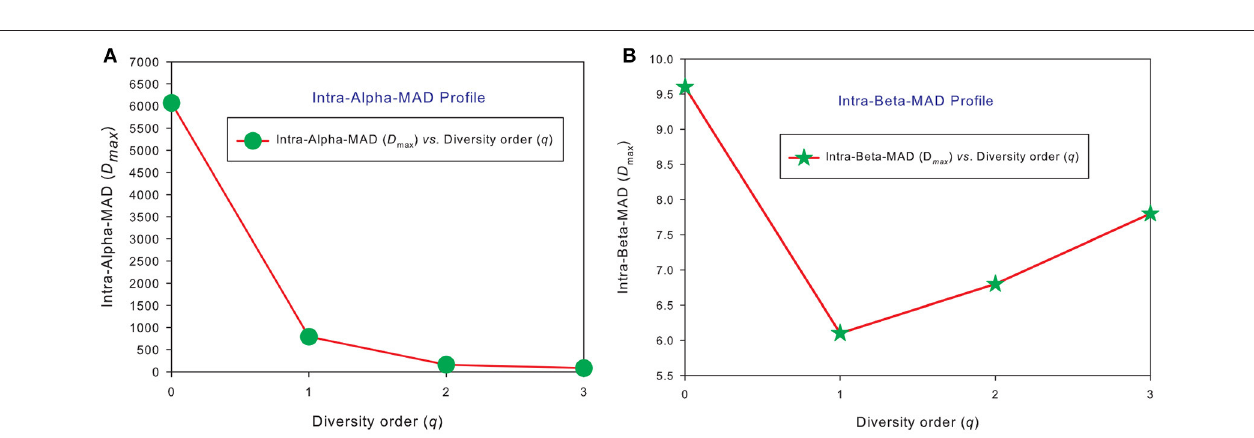
FIGURE 3 | The alpha-PDO profiles (A) and beta-PDO profiles (B) of 150 individuals in the HMP cohort: x-axis should be the subject ID of individuals but omitted to avoid overcrowded labeling, and y-axis is the PDO profile parameter ( g ) at four different diversity orders ( q = 0–3). Therefore, the four points corresponding to each subject ID on the x-axis is the PDO profile of that specific individual, and the four curves constitute the PDO profiles of 150 individuals in the cohort. Inter-individual heterogeneity in the PDO profile is also obvious, which is further described with the power law statistical distribution (see Table 4 , Figure 6 ).